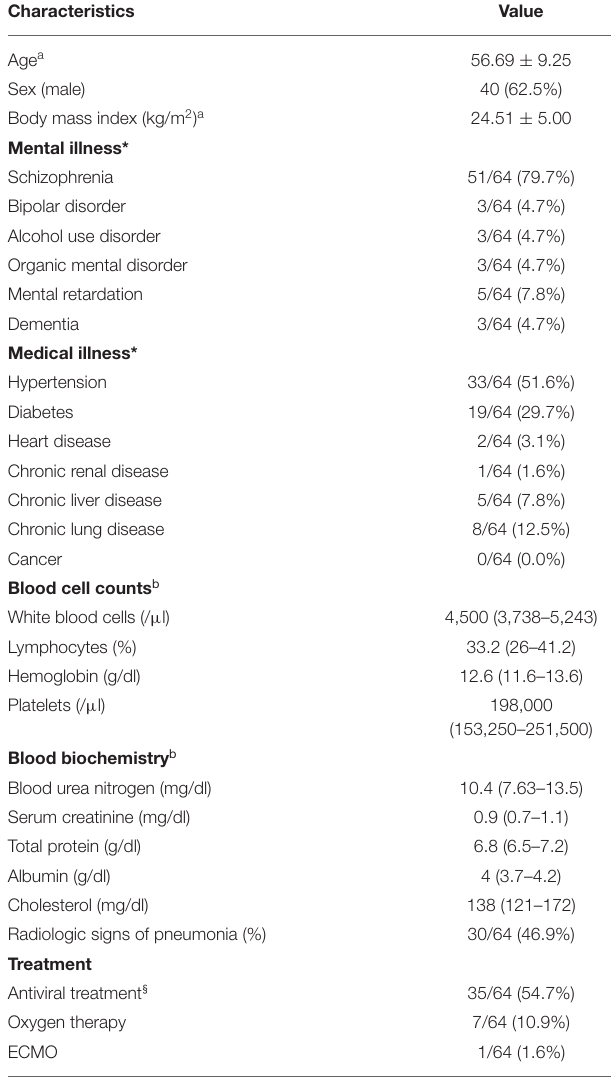
TABLE 1 | Baseline and clinical characteristics of 64 patients with